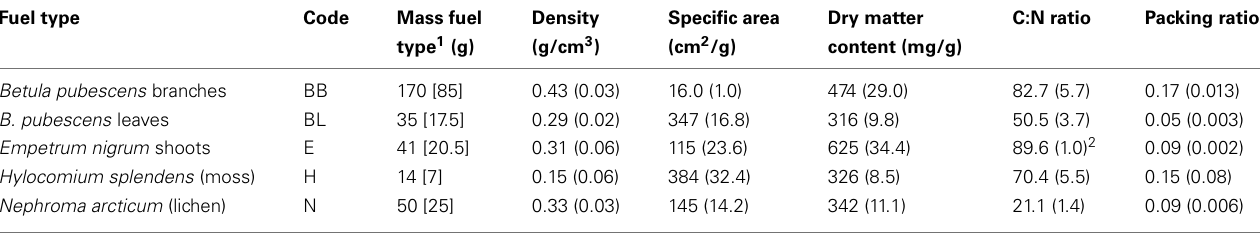
Table 1 | Different fuel types used together with codes, masses used for full and half-full rings and measured